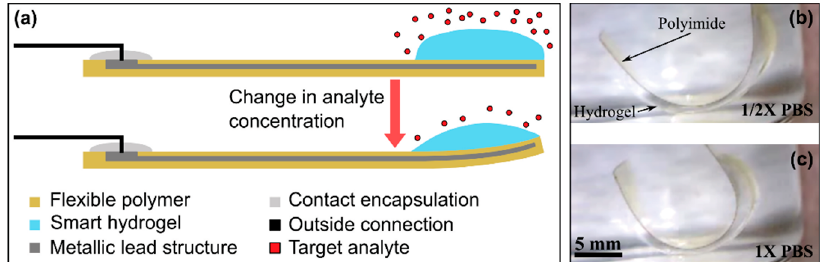
Figure 1. ( a ) Basic bending sensor concept, ( b , c ) polyimide sensing structure with hydrogel (no electrical contacts) immersed in different salt concentrations of phosphate buffered saline (PBS) solution to demonstrate the visual change in bending. The hydrogel is attached to the bottom side of the polyimide as